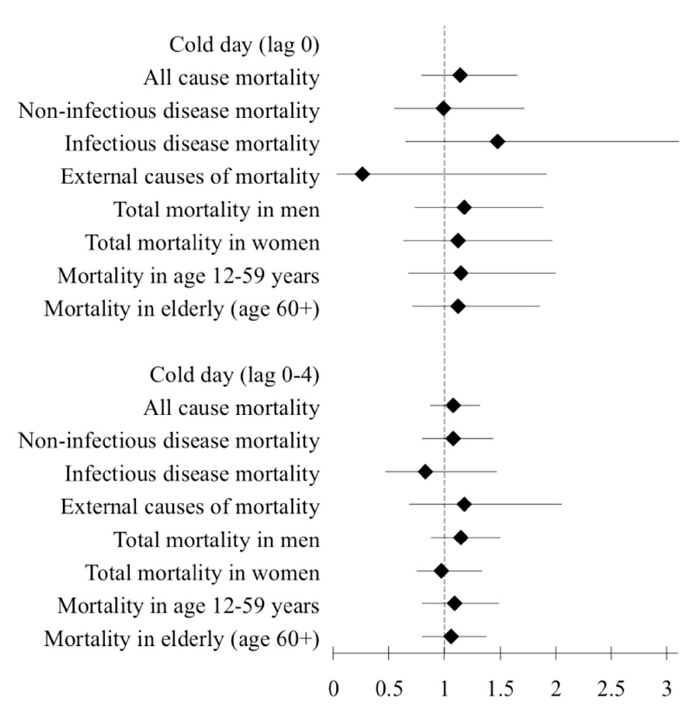
Figure 3. Association of cold (2nd percentile, <25 °C) with total, cause-specific, age and sex-specific mortality in Vadu HDSS 2003–2012.